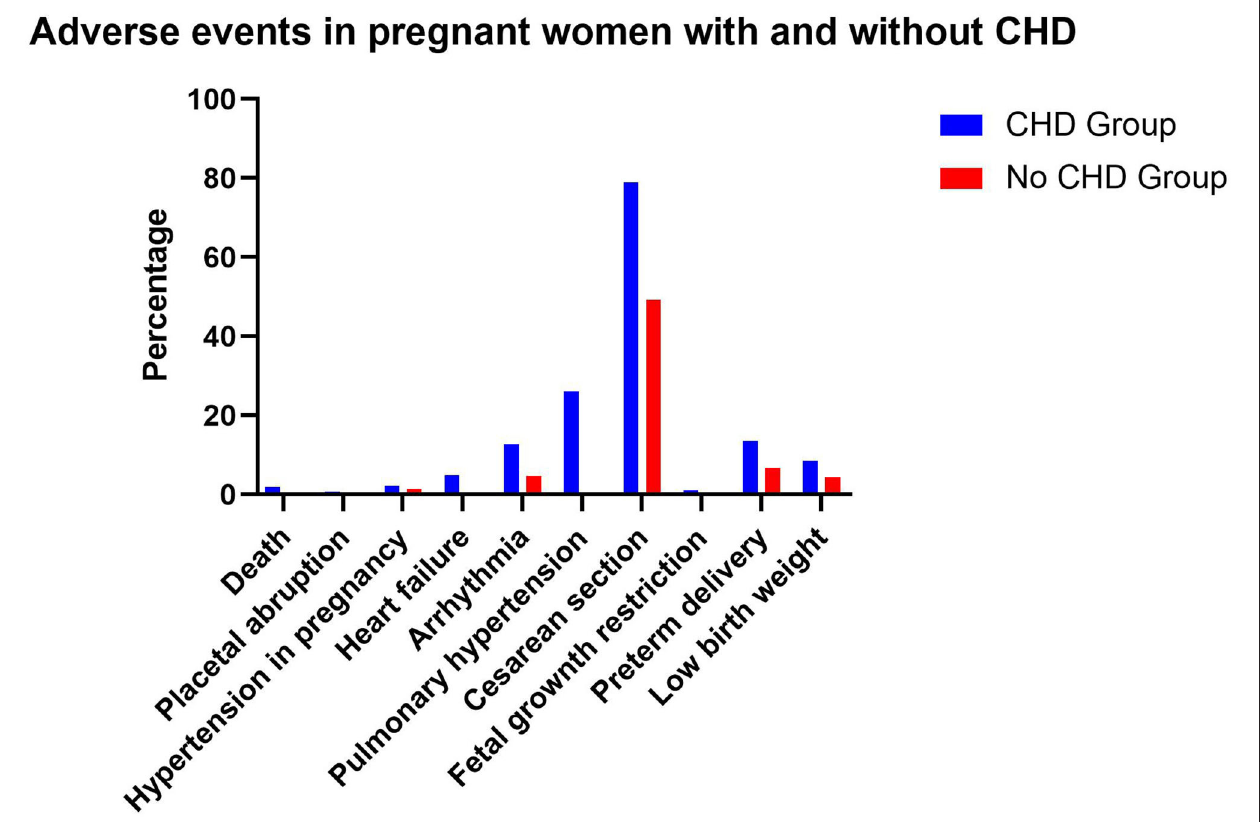
FIGURE 3 | Adverse events in pregnant women with and without